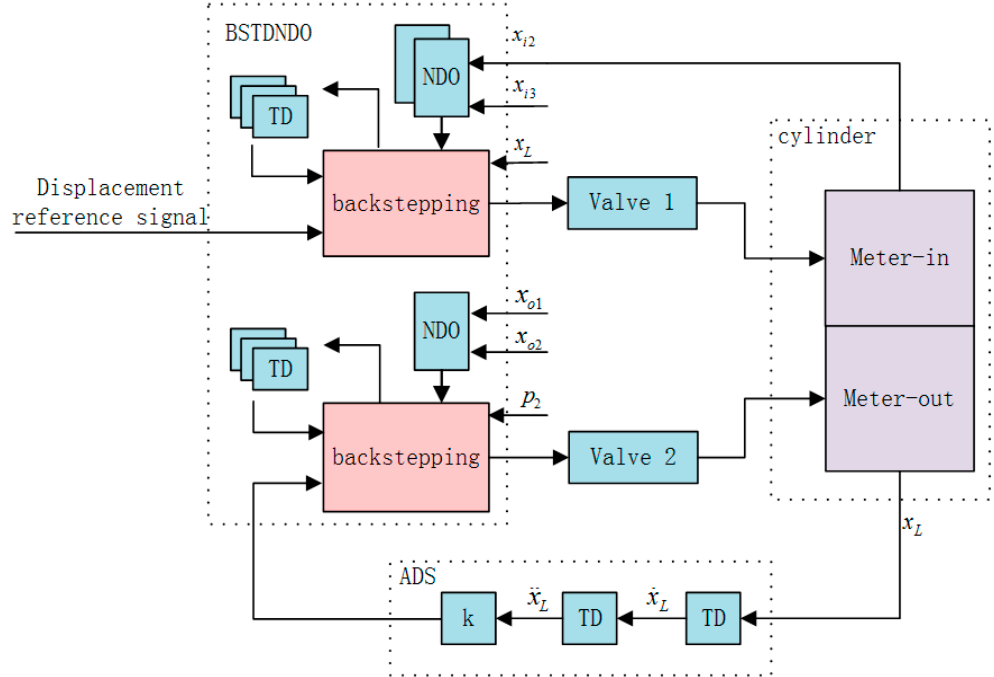
Figure 6. Block diagram of the proposed control strategy.